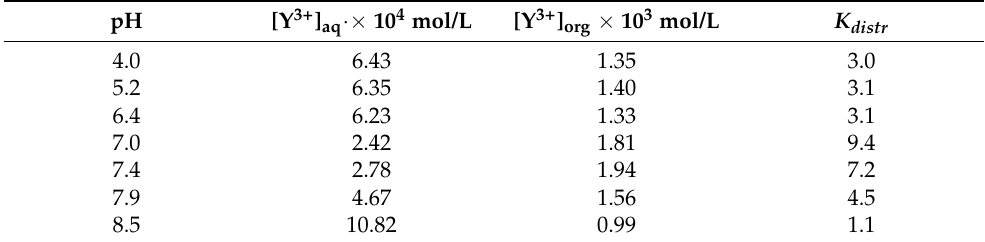
Table 4. The results of the experimental study of yttrium (III) cations recovery to froth pulp in nitrate-chloride medium at the NaCl concentration of 0.05